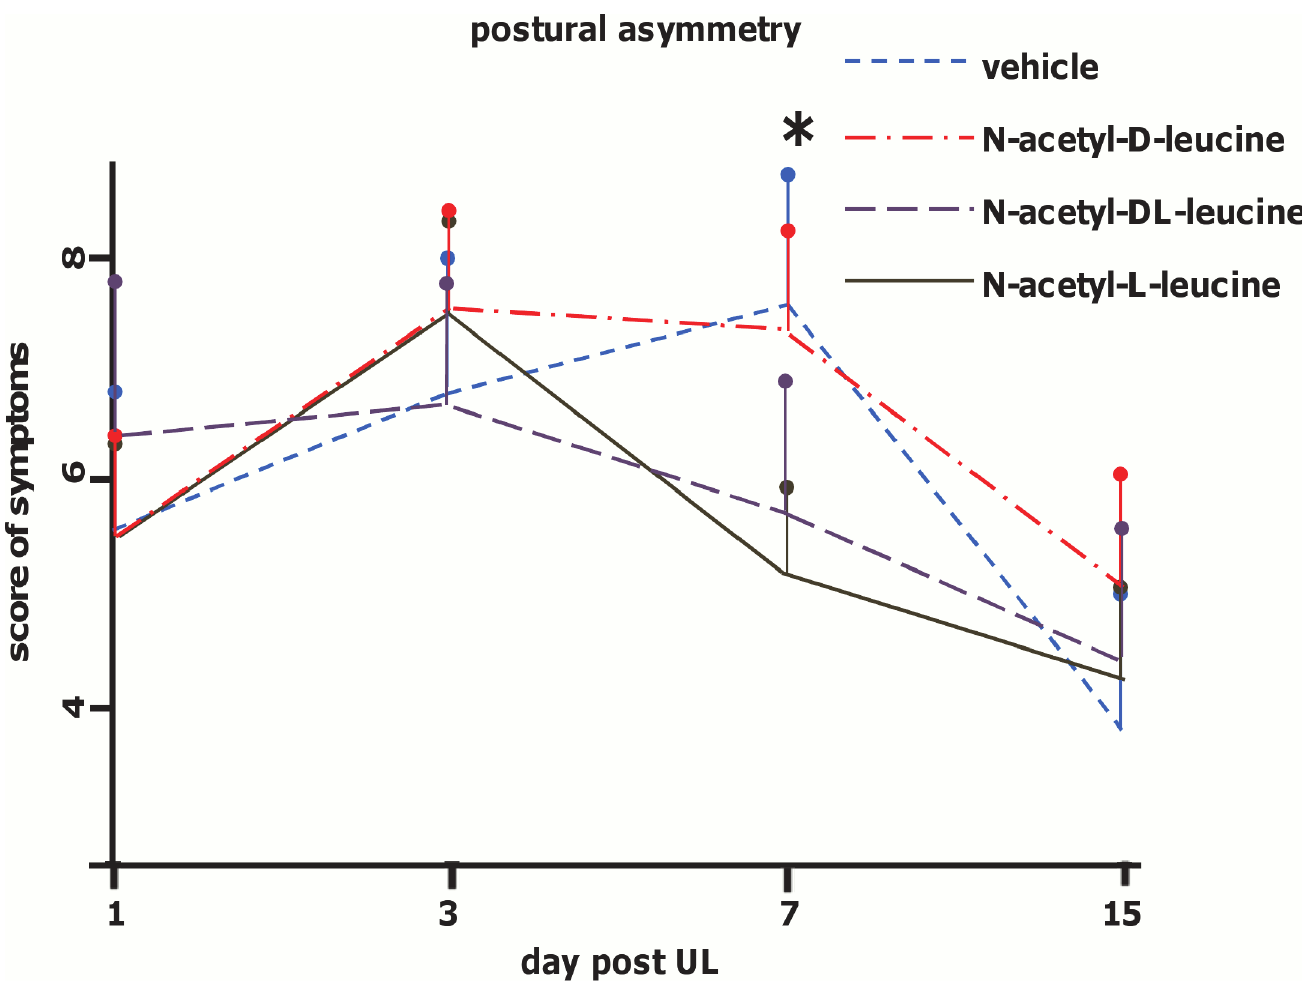
Fig 2. Postural imbalance scores after unilateral labyrinthectomy in the control and treatment groups. Sham treatment (vehicle), N-acetyl-DL-leucine, N-acetyl-L-leucine or N-acetyl-D-leucine (24 mg per rat each) was administered i.v. on days 1, 2 and 3 (six animals in each group). Postural imbalance scores were analyzed in all groups on days 1, 3, 7 and 15. Postural imbalance scores were significantly decreased in the N-acetyl-DL-leucine- (p < 0.03) and N-acetyl-L-leucine-group (p < 0.01) on day 7. Values are depicted as mean, the standard deviation as error bars. Significant values (DL-group vs. control and L-group vs. vehicle group on day 7) are marked with an